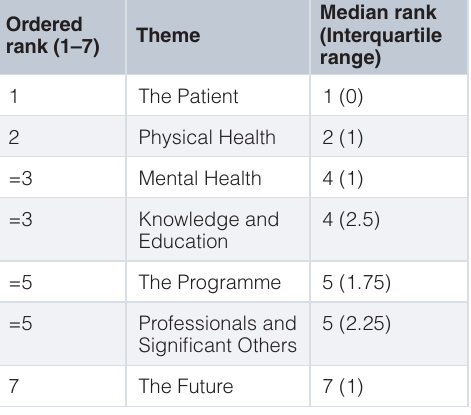
Table 4. Final ranked thematic list (n=12*). Ordered rank